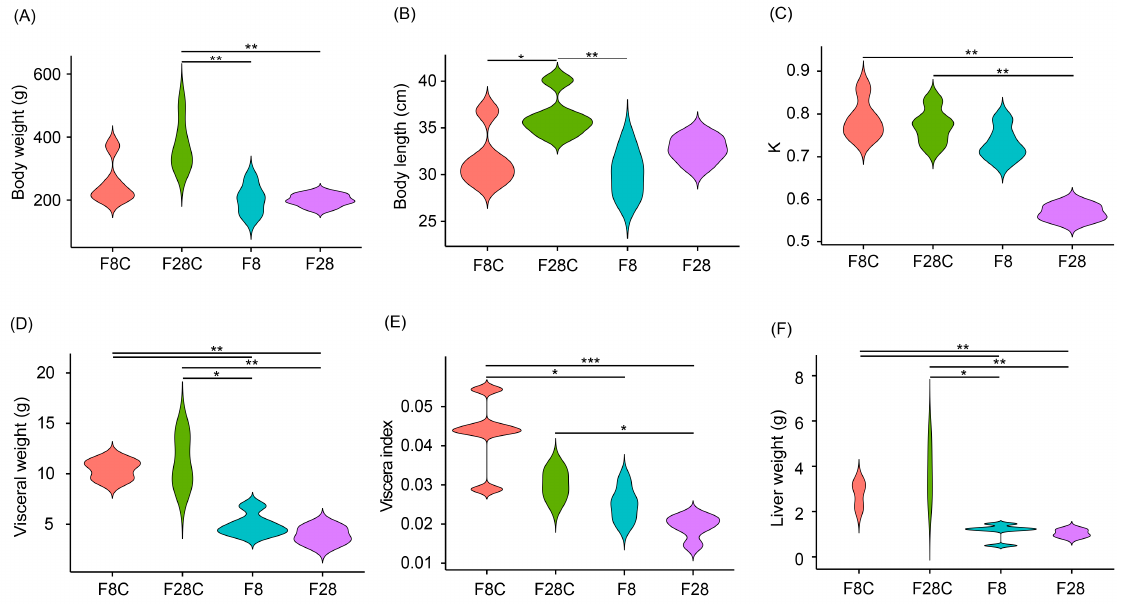
Figure 1. E ff ects of starvation on yellowcheek morphology. ( A ) Body weight, ( B ) body length, ( C ) Fulton’s condition factor (K), and ( D ) visceral weight; ( E ) viscera index calculated as ratio of viscera and body weight; ( F ) liver weight. F8C: un-starved yellowcheek samples collected on the 8th day after the starvation experiment; F28C: un-starved yellowcheek samples collected on the 28th day